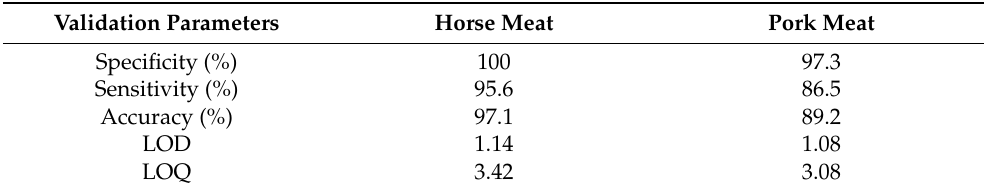
Table 11. Comparison of parameters characterizing the MSD for horse and pig meat. Validation